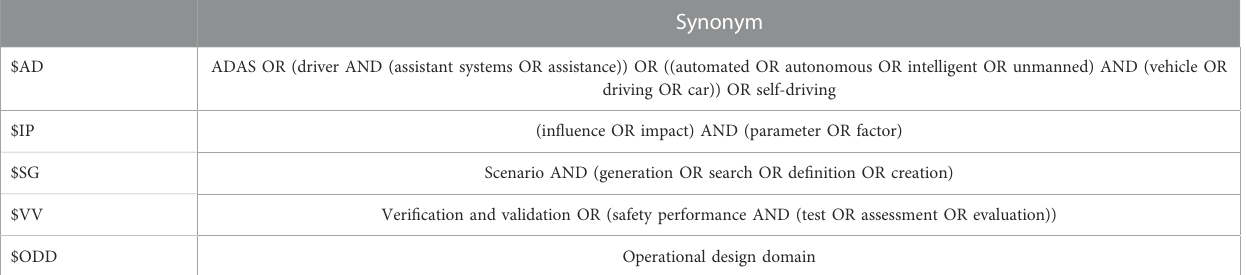
TABLE 1 Coverage of the knowledge of the 25 surveyed experts in different study fi elds.